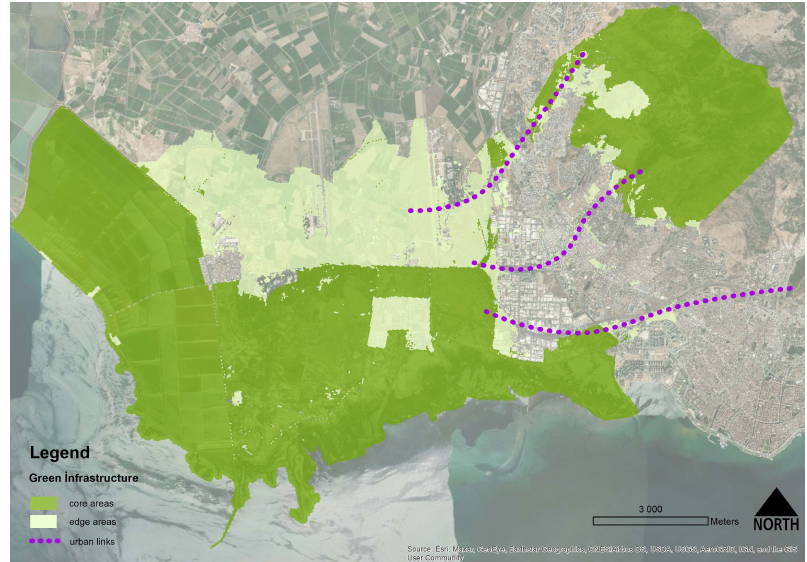
Figure 9. The Green Infrastructure design (source: author’s elaboration).